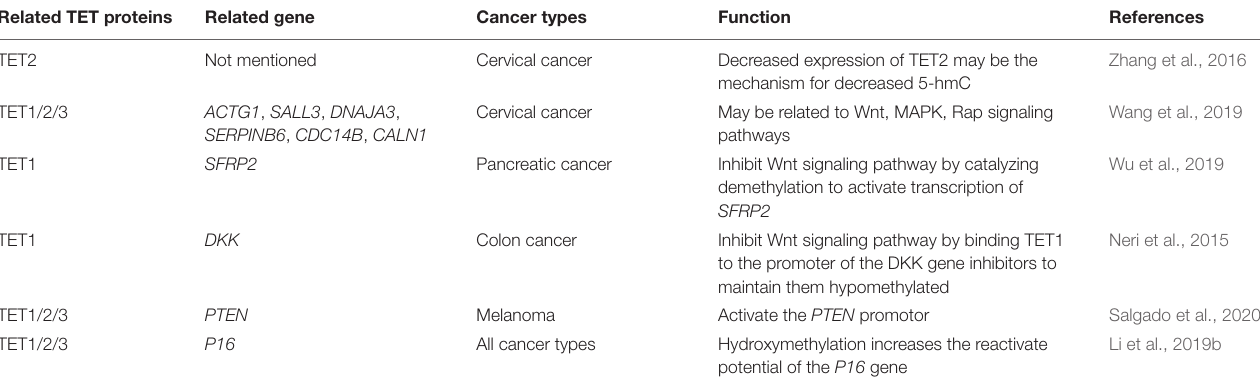
TABLE 4 | The function of DNA hydroxymethylation in various kinds of